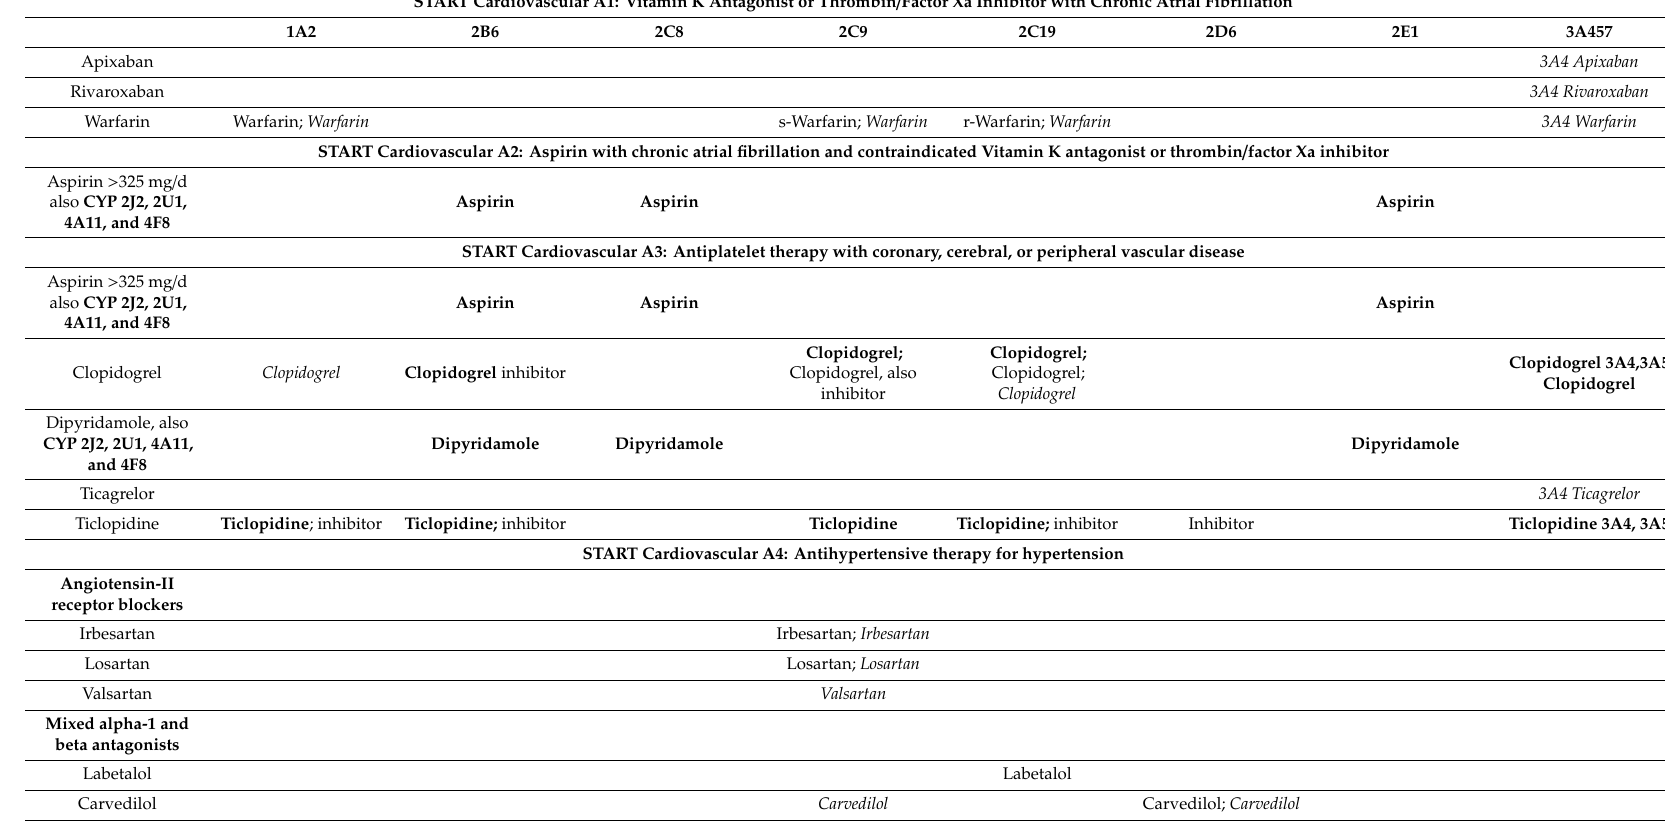
Table 6. START 2015 criteria for Potential Prescribing Omissions in older adults for which the P450 cytochrome isoform is known. Sources: Bold print = DrugBank [25]; Regular print = Flockhart Table [26]; Italic Print = Rx Files. 12th ed. [27]. If a medication name is given it indicates it is a substrate metabolized by the P450 cytochromes in the columns listed. If a medication is also an inducer of individual P450 cytochromes the word inducer is used. If a medication is an inhibitor of individual P450 cytochromes the word inhibitor is used. (Inhibitors increase levels of medications metabolized by the same isoform. Inducers decrease levels of medications metabolized by the same isoform). However, if they metabolize a prodrug (e.g., codeine) the result is higher levels of its metabolites (e.g., morphine).